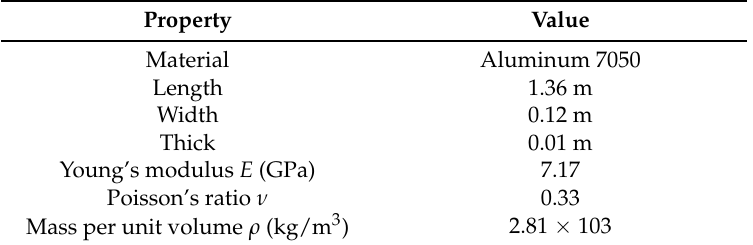
Table 3. Dimensions and properties of the aluminium alloy beam.